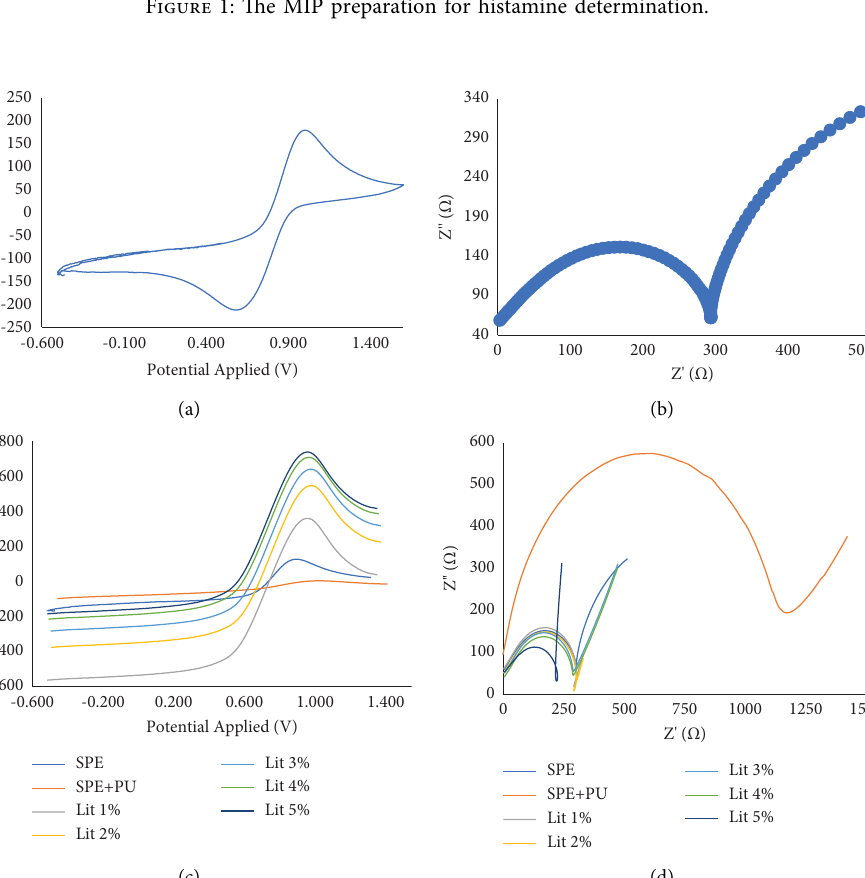
Figure 1: Te MIP preparation for histamine determination.